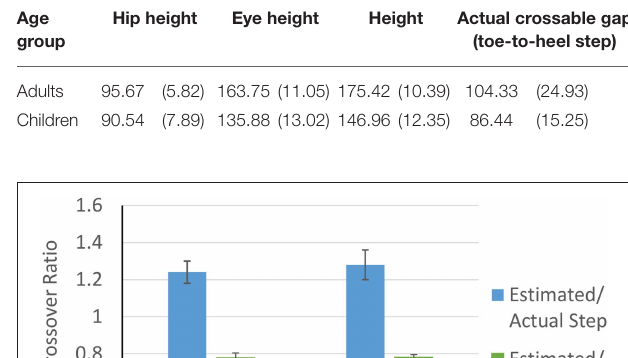
and adults ( M = 1.28) in the crossover ratios scaled to actual step, t (22) = − 0.35, p = 0.73 (M_ diff = − 0.035, SE_ diff = 0.10). There was also no difference between children ( M = 0.78) and adults ( M = 0.78) in the crossover ratios scaled to eye-height, t